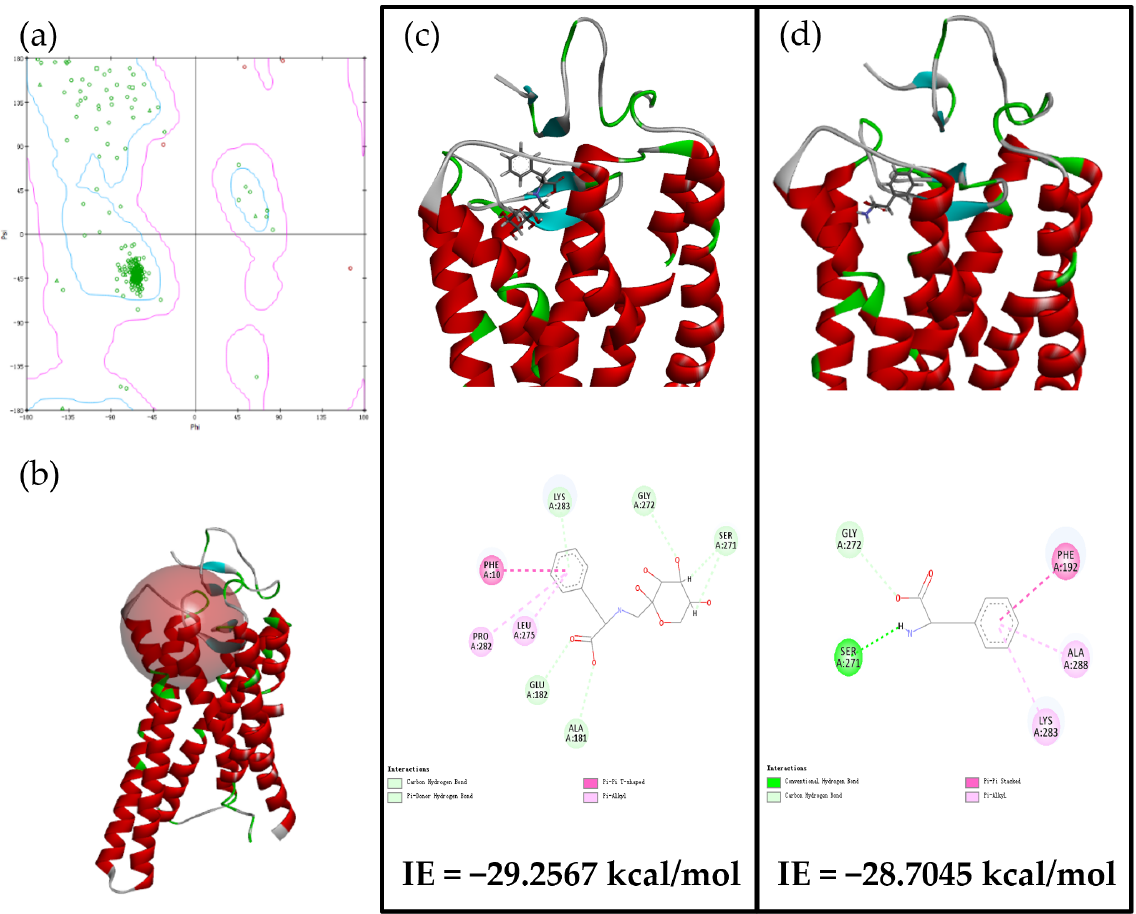
Figure 4. ( a ) The Ramachandran plot of the hT2R1 model, ( b ) the active sphere of the hT2R1 model, ( c ) molecular docking results and IE of Glu-Phe ARPs and ( d ) Phe in the hT2R1 receptor active site.